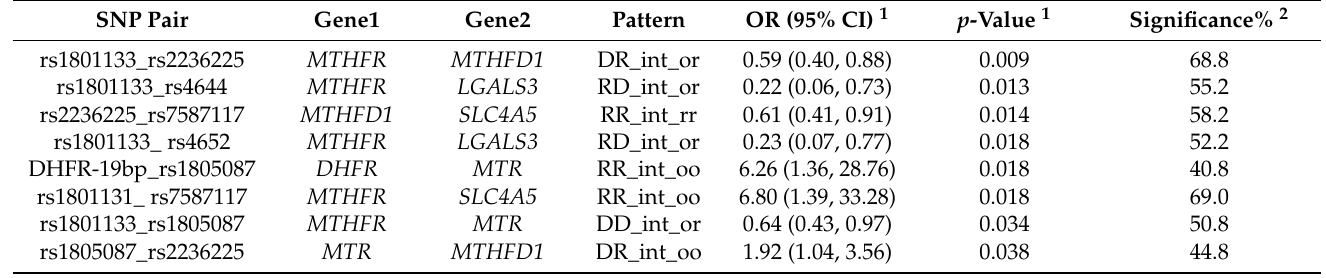
Table 4. SNP–SNP interactions associated with prostate cancer aggressiveness in European Americans.